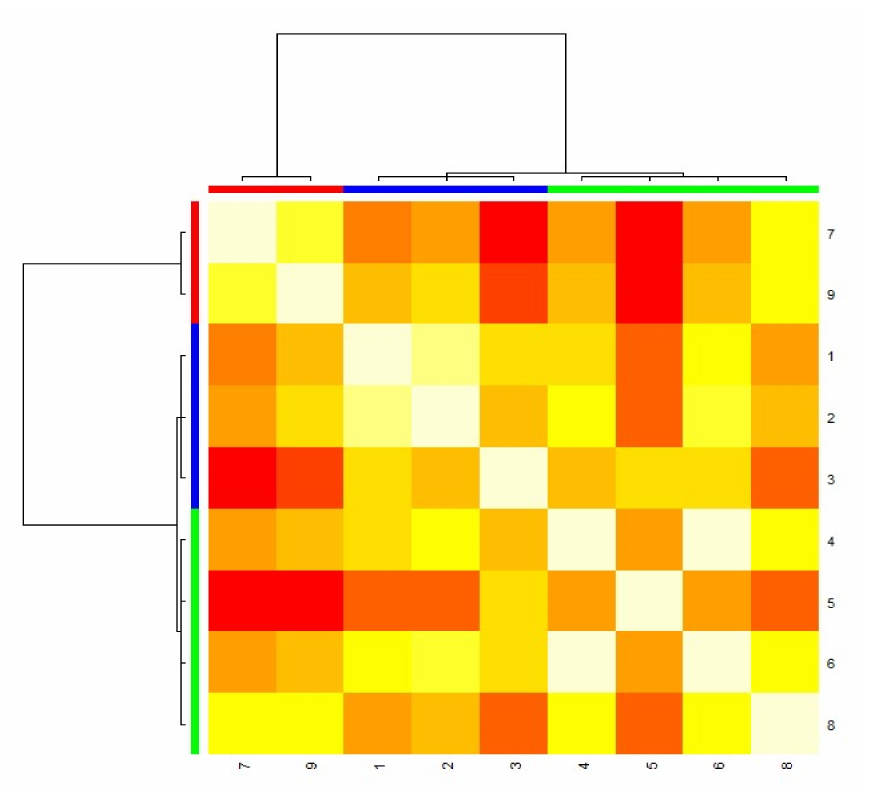
Figure 4. Cluster heatmap of the nine OA runs simultaneously taking in account the response of the three water quality indices.